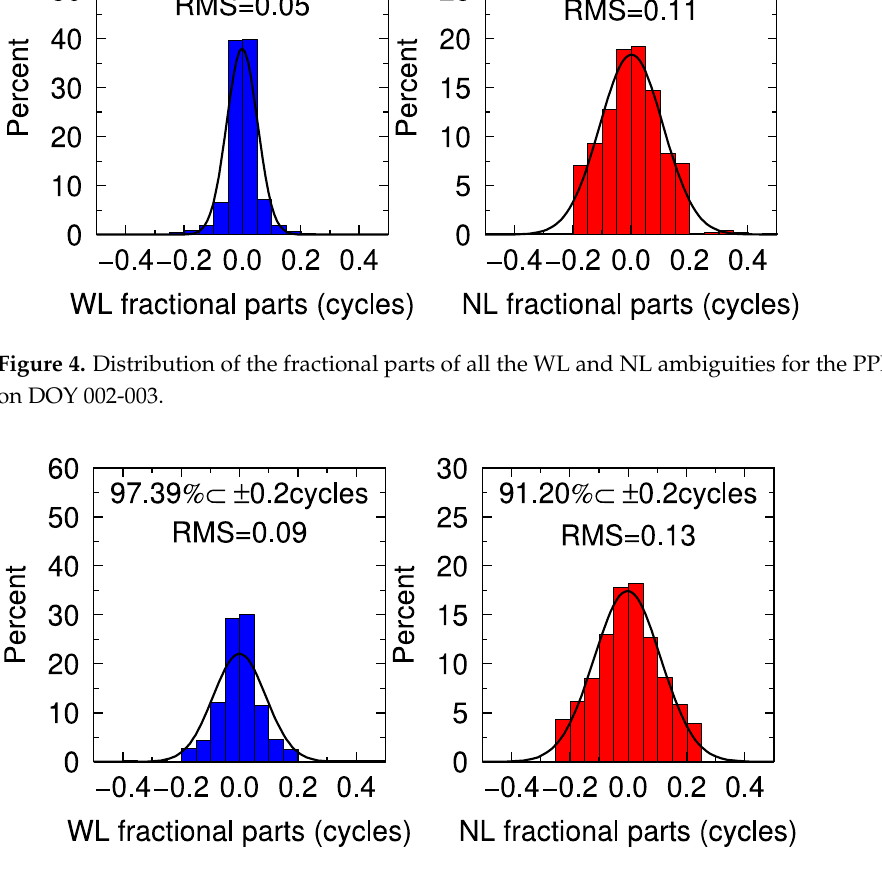
Figure 6. Nearly 100% WL ambiguities are close to an integer within 0.2 cycles, and more than 98% of NL ambiguities within 0.2 cycles. Meanwhile, the fractional parts of all the ambiguities from Figure 4 to Figure 5 are satisfied the normal